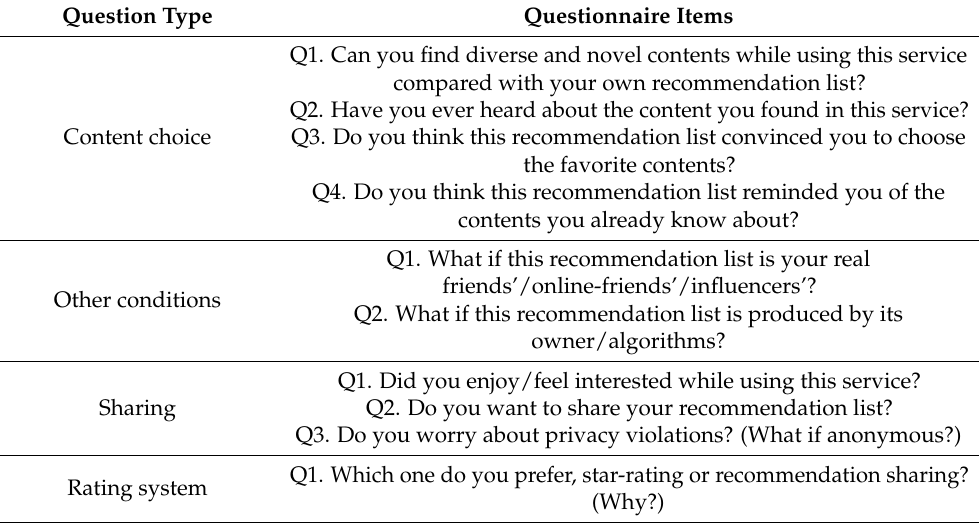
Table 3. Results of the mediation analyses of the effects of information quality and perceived play- fulness on intention to use for H2a and H2b.